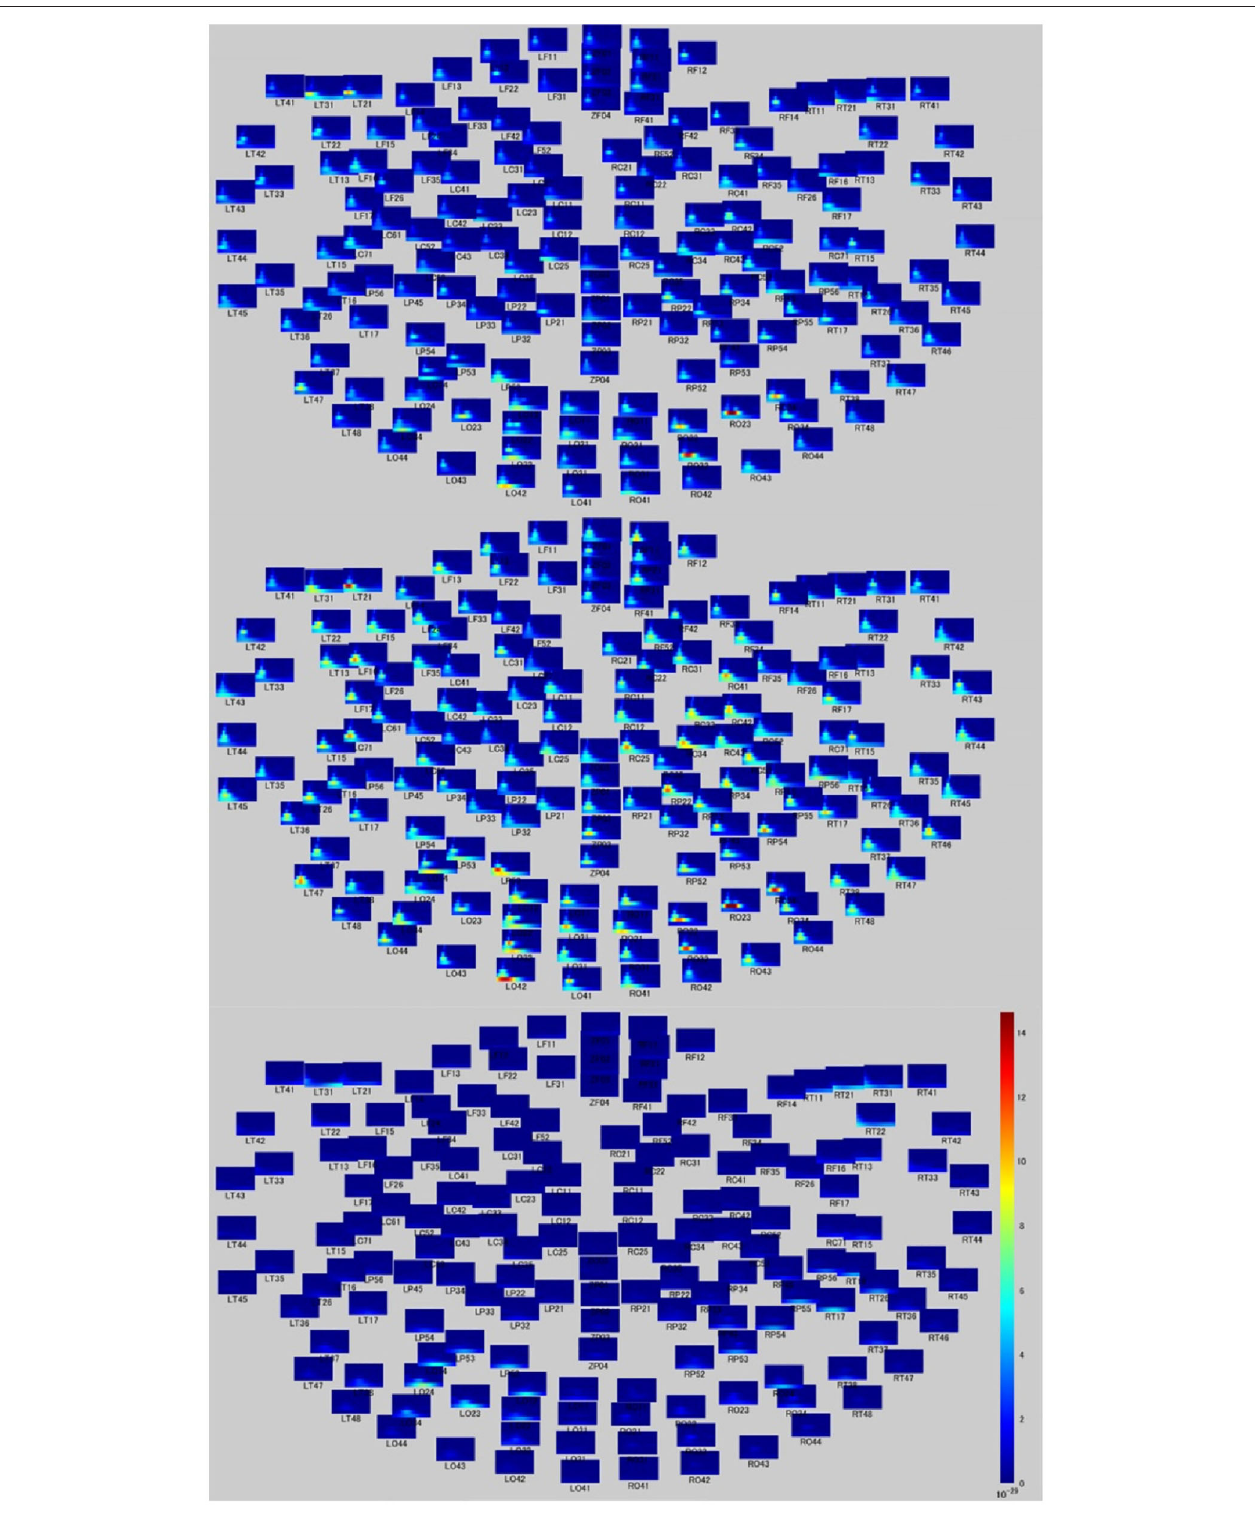
FIGURE 2 | Time-frequency relationship map during moral judgment. Time-frequency figures on whole head during MGJ (upper), MBJ (middle), and MNJ (lower) conditions. The X -axis of each small panel indicates the time from 200 ms before to 1,000 ms after a phase three picture presentation, and the Y -axis indicates the Hz from 0 to 120. The color bar denotes the power (signal units 2/Hz × 10–29) from 0 to 15. (A) The third frame that represents a morally good situation. (B) The third frame that represents a morally bad situation.